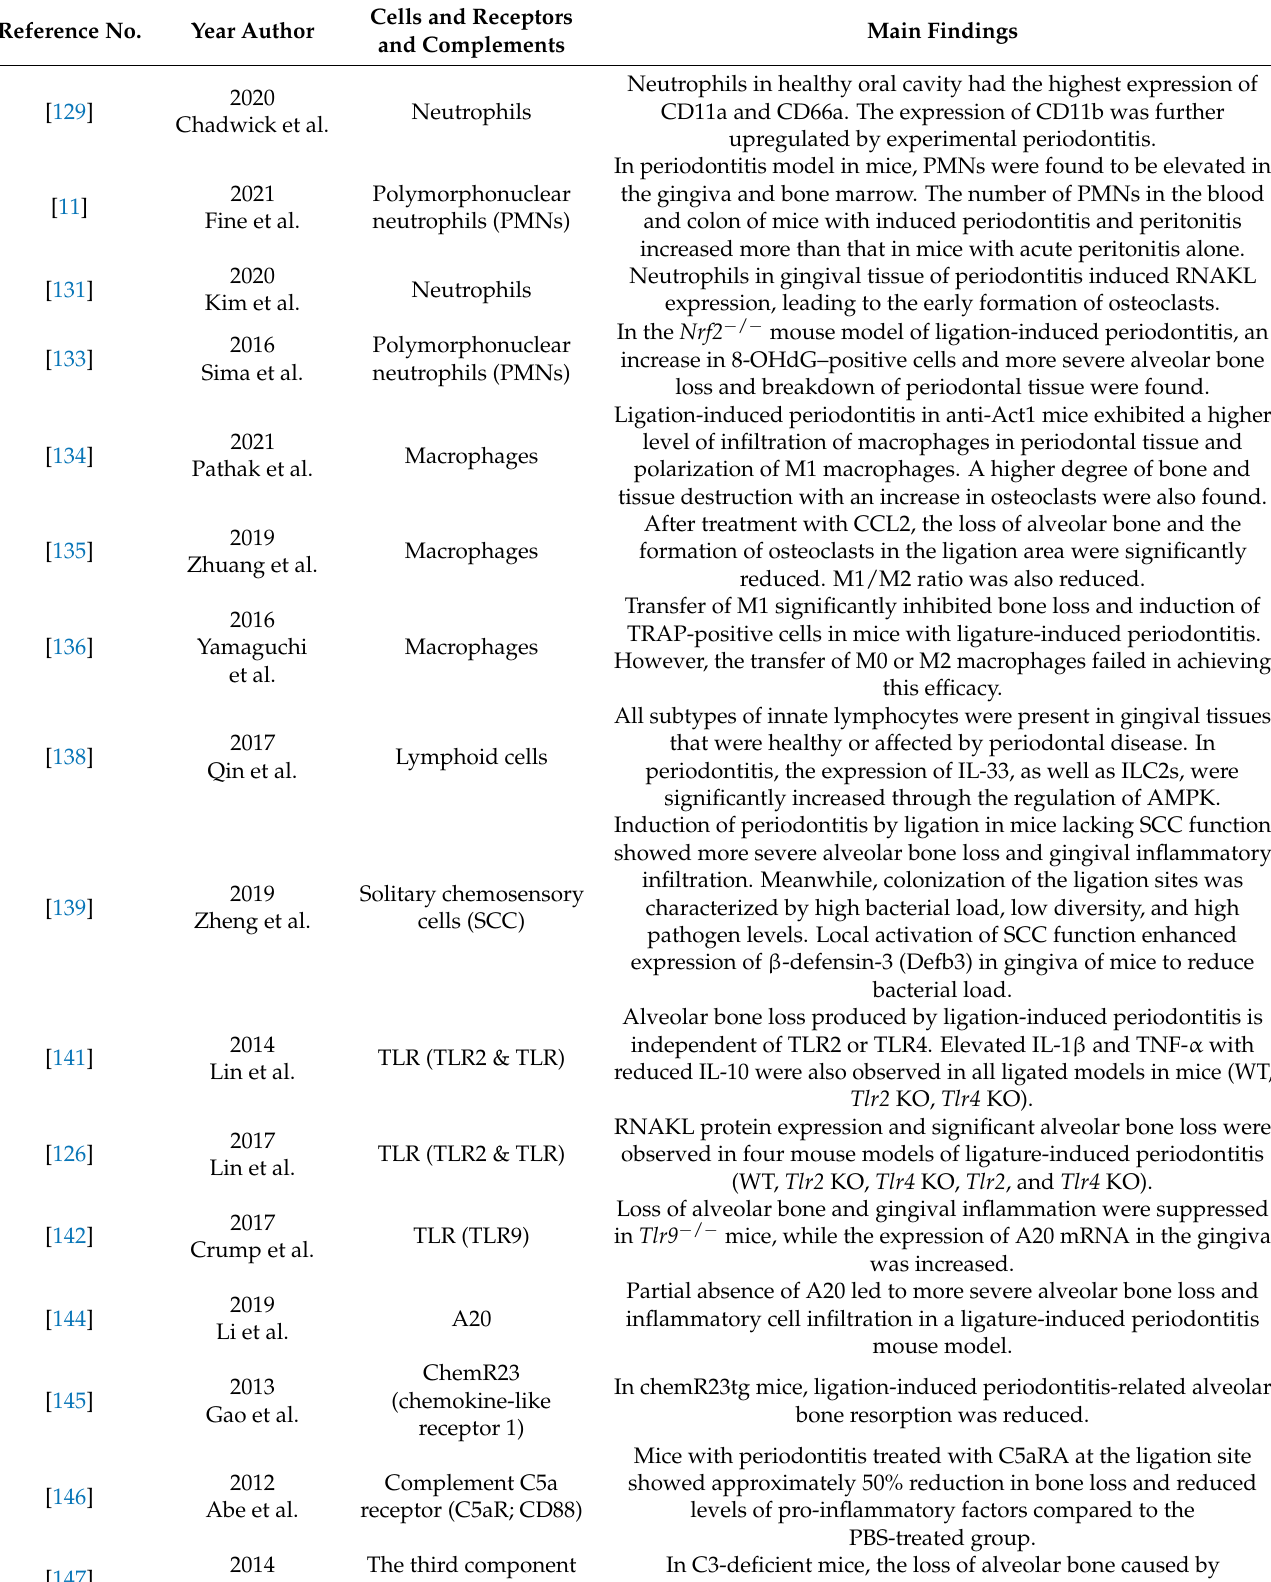
Table 4. Summary of innate immunity in ligature-induced periodontitis model in mice. Reference